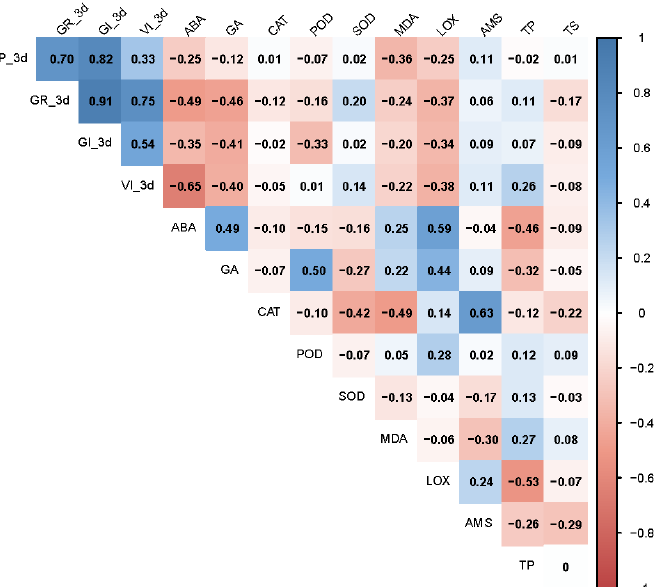
Figure 6. Correlation analysis of seed vigor indexes and physiological indexes in seeds subjected to artificial aging.